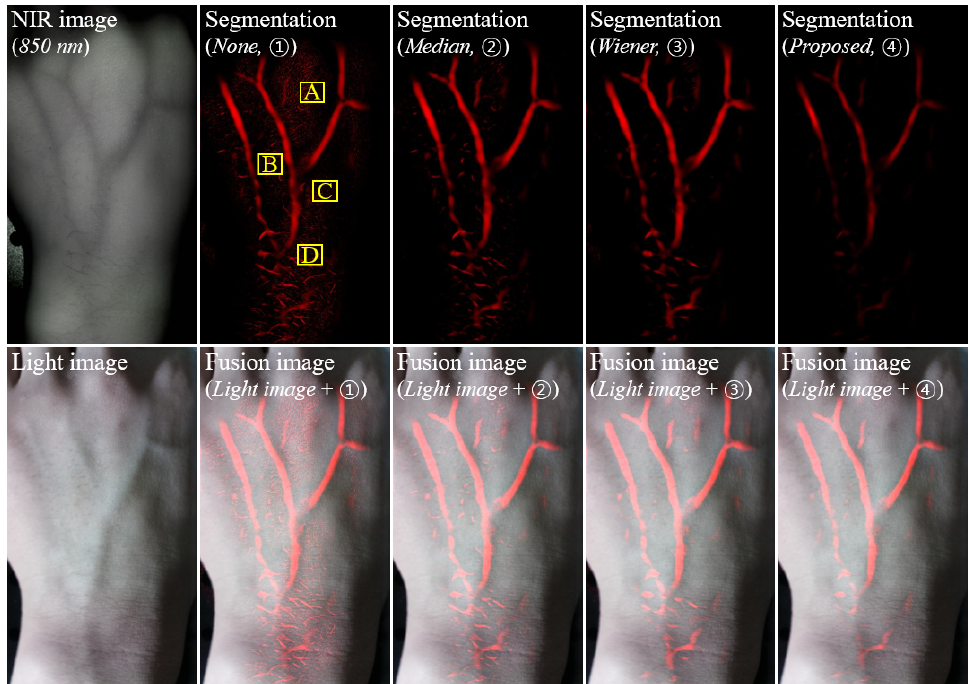
Figure 3. Vein segmentation images ( top ) of the left hand for an 850 ‐ nm NIR image (none ① ), the median filter ( ② ), the Wiener filter ( ③ ), and the proposed relative total variation (RTV) regularization ‐ based smoothing algorithm ( ④ ), which were acquired using our established miniaturized vein imaging system and the synthesized images of blending them with a light image ( bottom ).